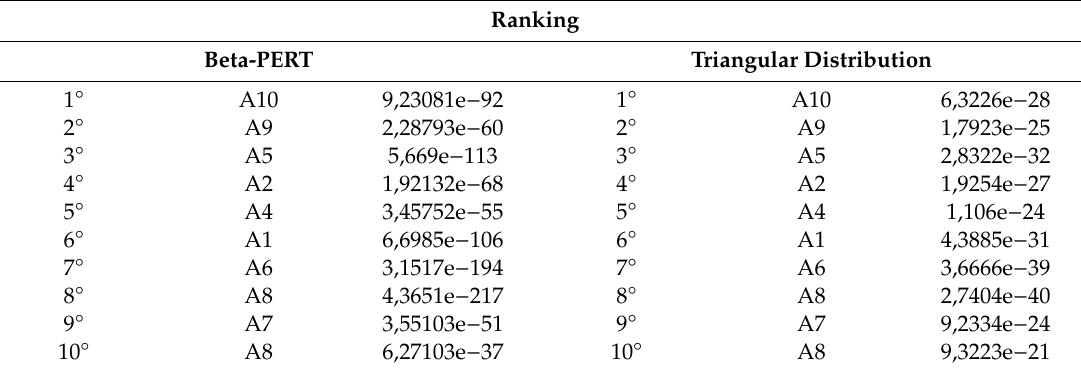
Table 12. Beta-PERT and triangular